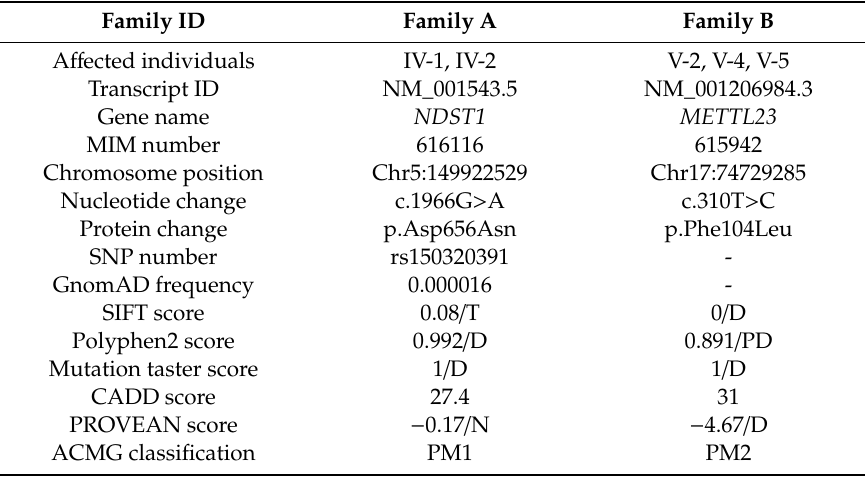
Table 2. Homozygous sequence variants identified in families A and